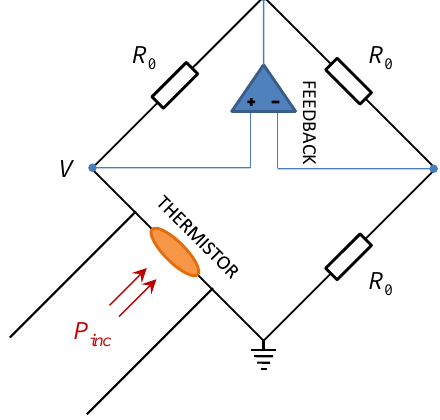
Figure 2. Principle of bolometric (thermistor) power detection [1].